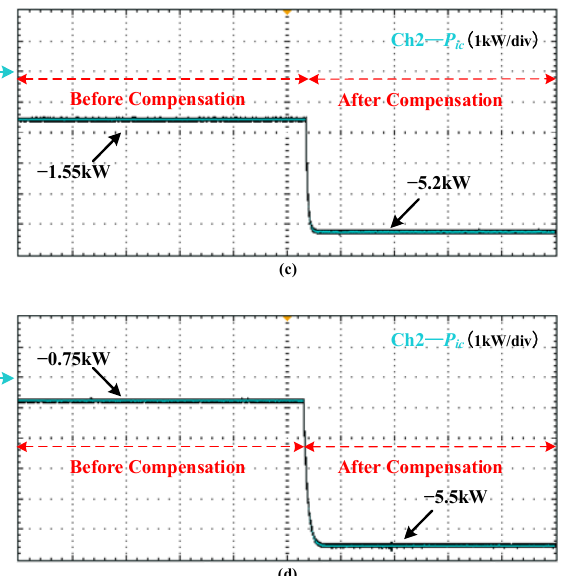
Figure 12. Voltage compensation results of different resistances ( x -axis: time, 1 s/div; y -axis: magni- tude of the measured signal): ( a ) R line = 0.1 Ω ; ( b ) R line = 0.5 Ω ; ( c ) R line = 2 Ω ; (d) R line = 5 Ω .